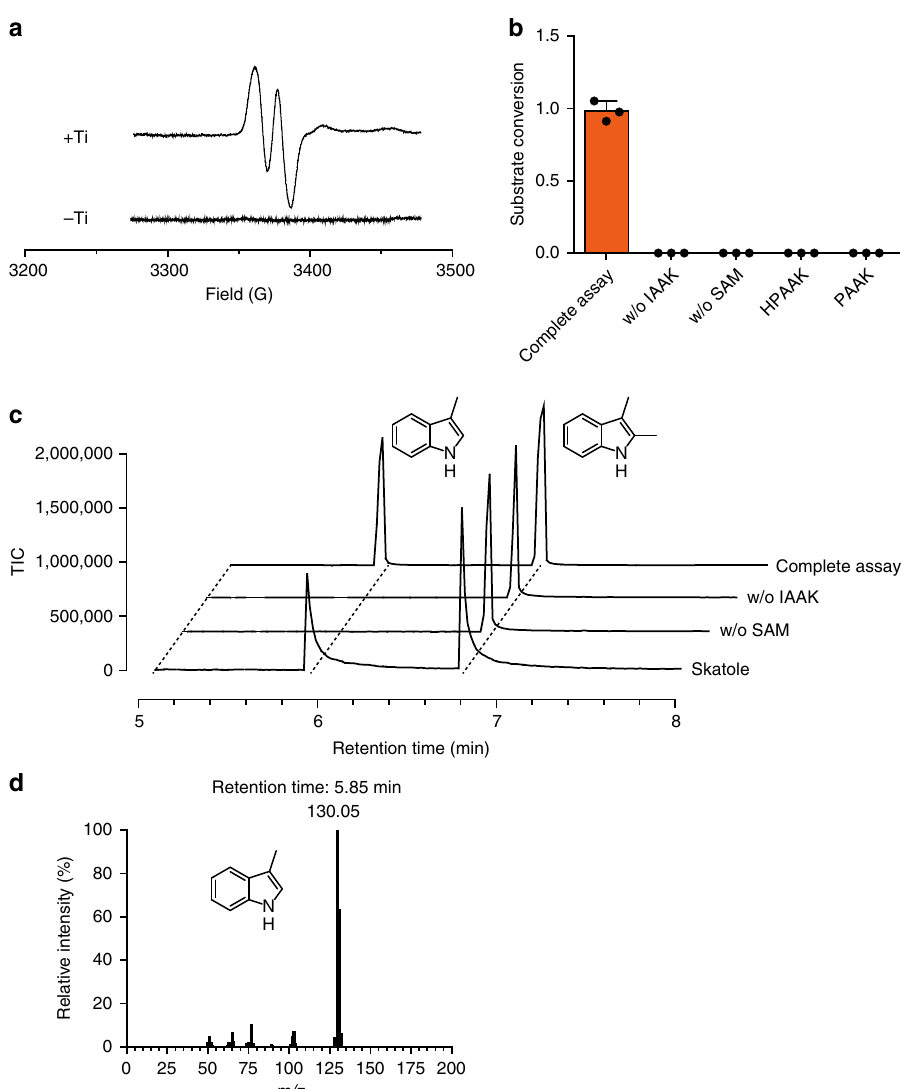
Fig. 4 EPR spectra and enzymatic assays of Os IAD. a X-band EPR spectra of IAD reconstituted with IADAE and SAM in the presence or absence of reductant (Ti(III) citrate). b Reaction requirements and substrate speci fi city of IAD. IAAK, HPAAK, and PAAK are the potassium salts of indoleacetic, p -hydroxyphenylacetic, and phenylacetic acids, respectively. (The error bars represent the standard deviation of three individual experiments.) c Detection of skatole formation in the IAD-catalysed decarboxylation of IAAK using GC-MS. GC-MS elution pro fi les of authentic standards of skatole, negative controls omitting SAM and IAAK and a complete assay are displayed as labelled. The internal standard 2,3-dimethylindole is included in each sample. d Mass spectrum of the skatole